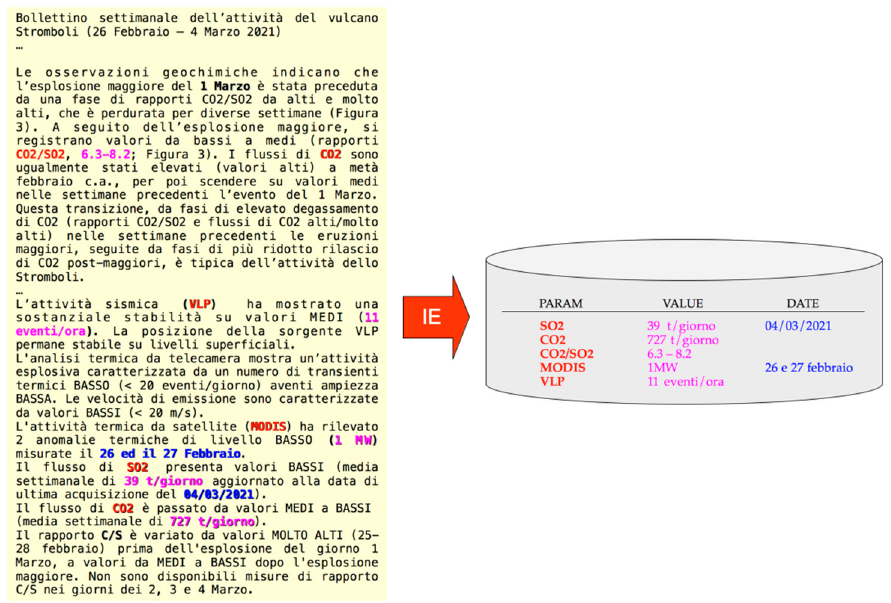
Figure 1. Information extraction: filling slots in a database from an unstructured text. On the left, the original text of the input volcanological bulletin is in Italian language. Italian terms on the right refer to: t —tons; giorno —day, eventi —events; ora —hour; febbraio —February.